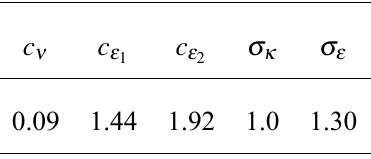
Model constants for single phase